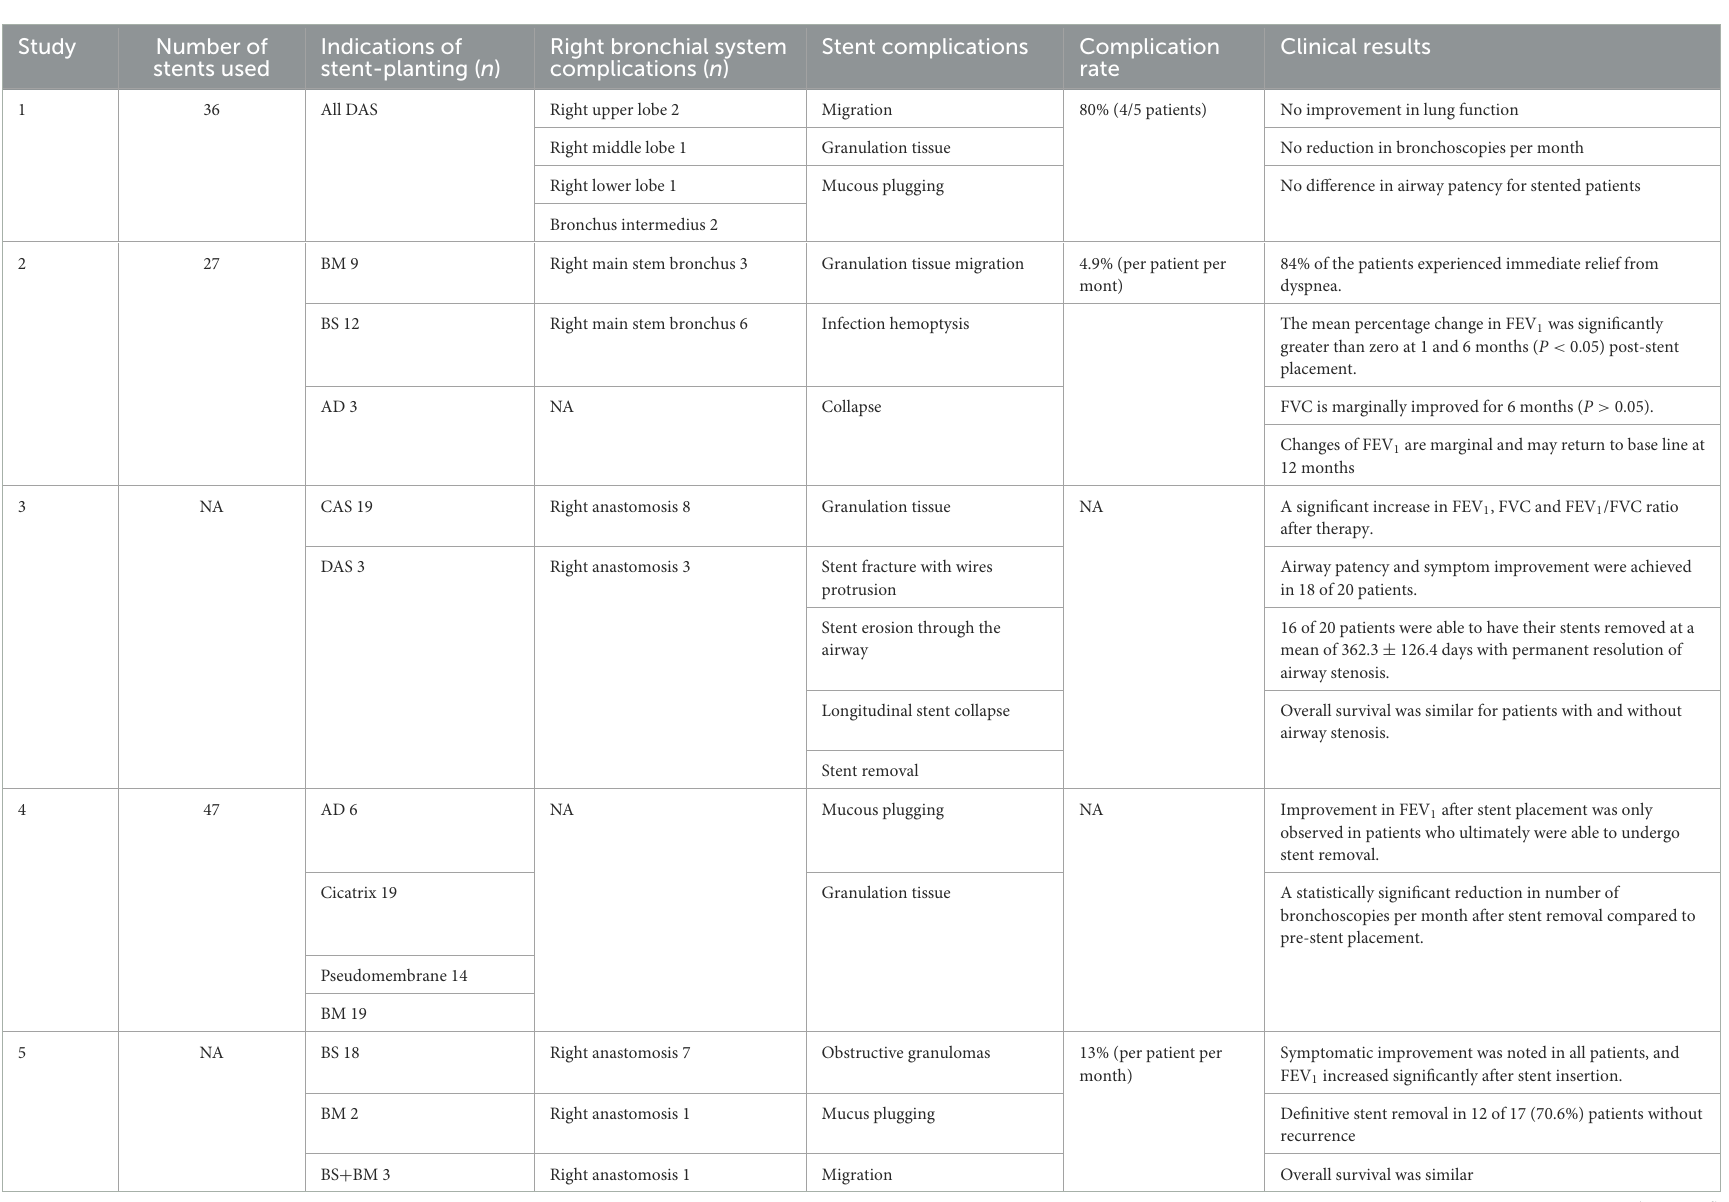
TABLE 3 Stents-related contents and clinical